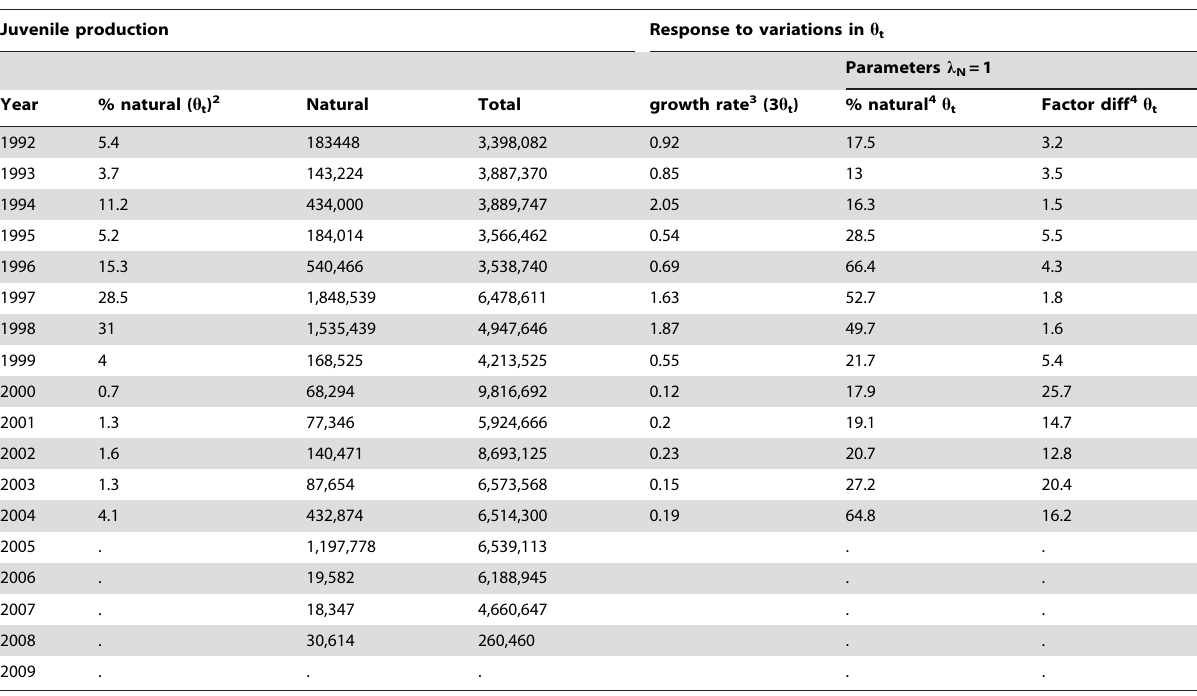
Table 3. Percent natural-origin salmon and influence on population growth rate